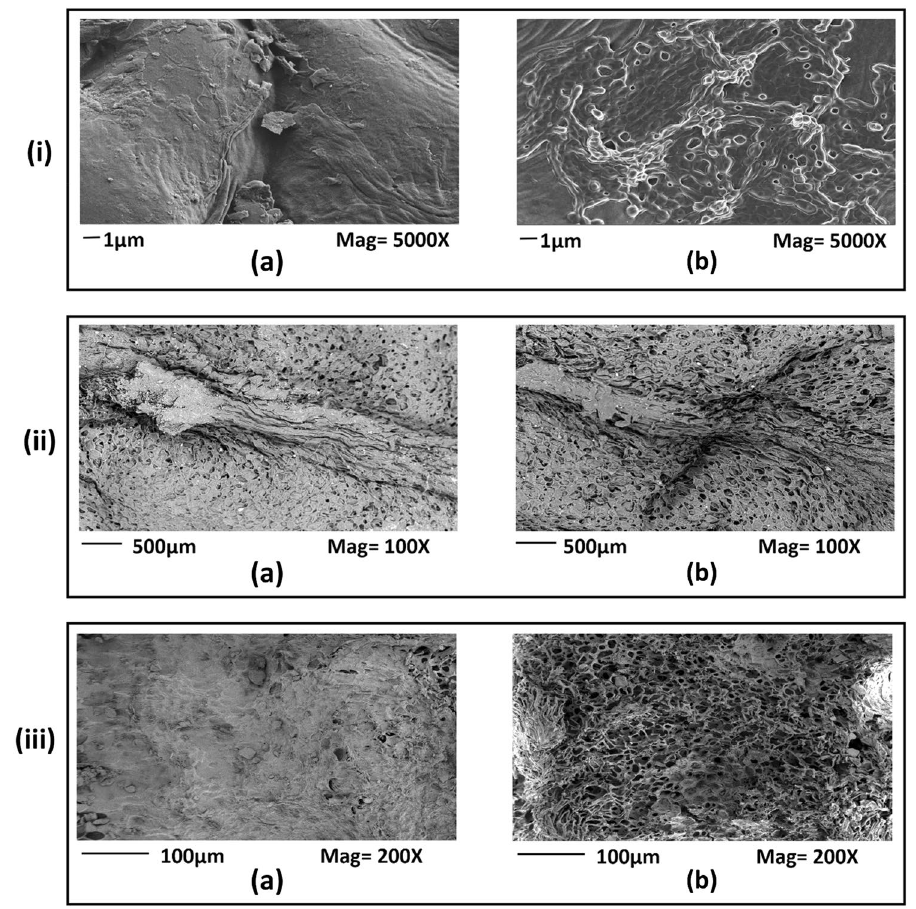
Figure 4. The difference between untreated and plasma-treated surfaces for Bambara, chilli and papaya was illustrated in sub-figures ( i ), ( ii ), and ( iii ), respectively. In sub-figures ( i ), ( ii ), and ( iii ) ( a ) represent the untreated seed surface, while ( b ) represent the surface of the plasma-treated seed. Bambara groundnuts were treated with water plasma, while the chilli and papaya were treated with oxygen